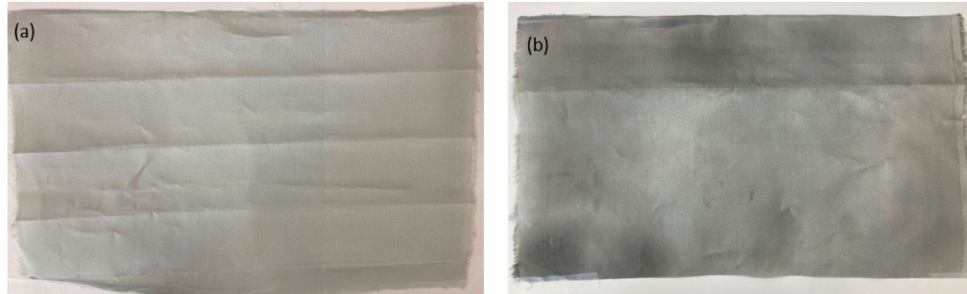
Figure 6. Electron micrographs of the fabricated shielding fabrics. ( a ) Fabric without dispersed tungsten powder, ( b ) Fabric with dispersed tungsten powder.